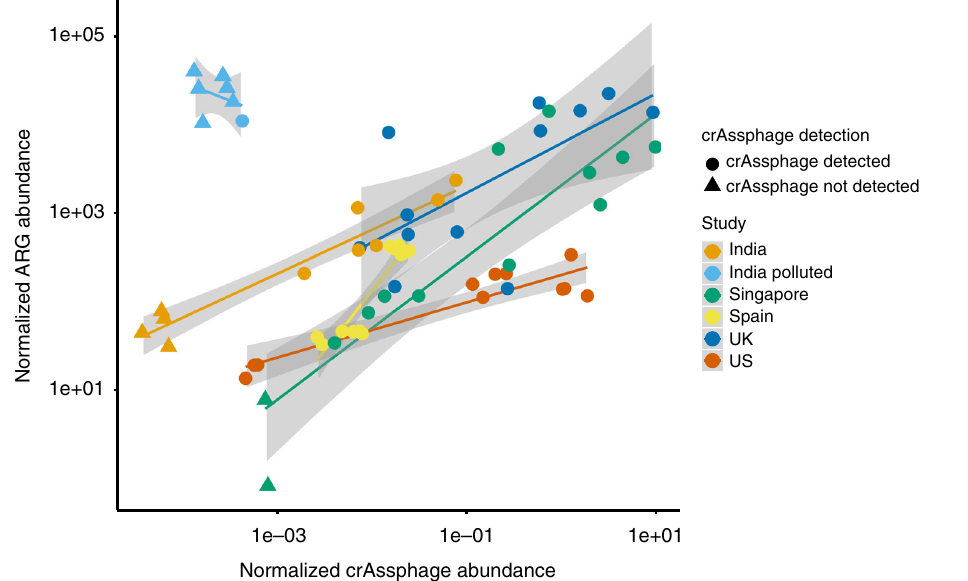
Fig. 2 Correlation between ARG abundance and crAssphage abundance in environments with pollution from WWTPs, hospitals, or drug manufacturing. The environments effected by drug manufacturing are polluted with exceptionally high levels of antibiotics, and the analyses show clear selection for antibiotic resistance as the ARG abundance cannot be explained by fecal pollution. ARG abundance and crAssphage abundance were normalized with total nucleotide count in the metagenomes. For samples where we did not detect crAssphage (indicated by triangles), half of the detection limit (corresponding to one read mapping to crAssphage) was used and normalized to the total nucleotide